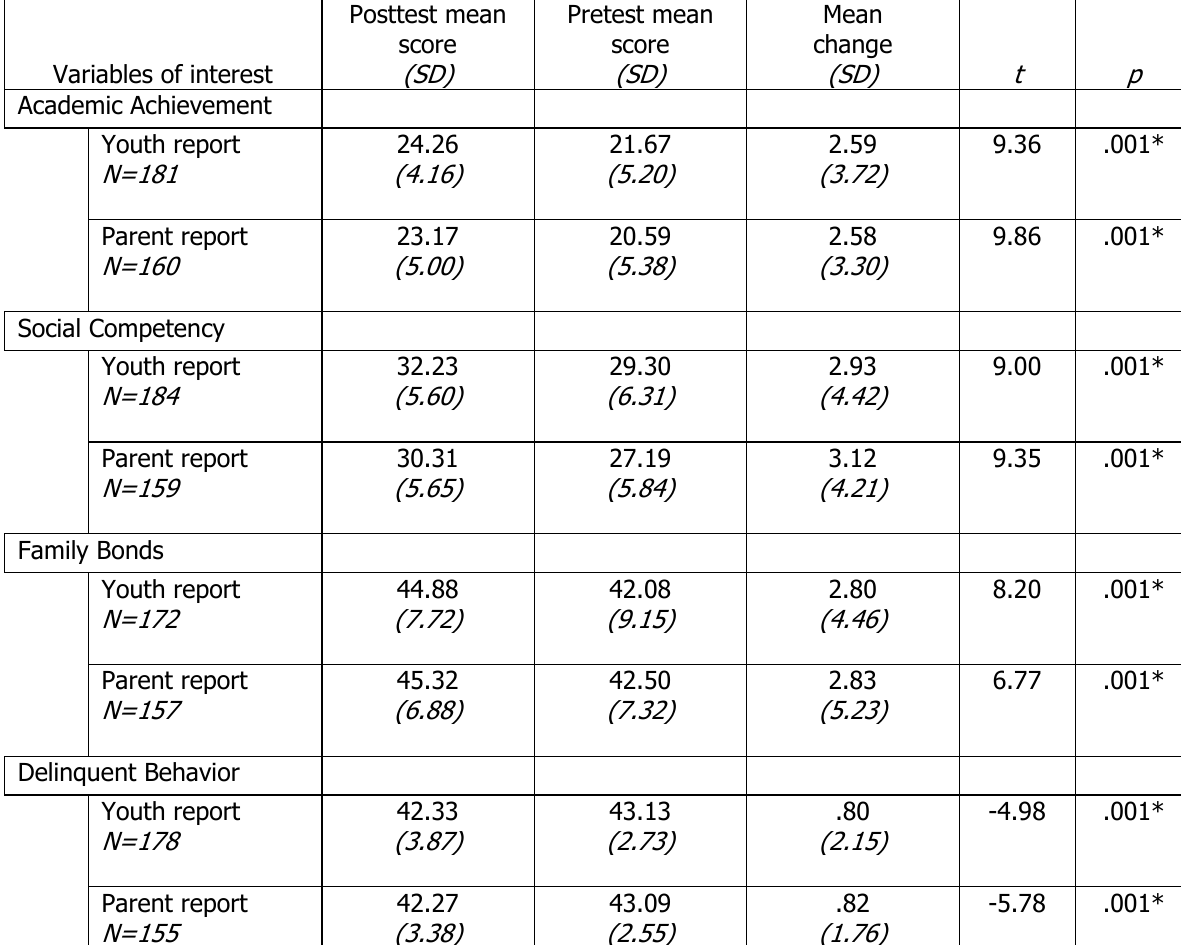
Paired-samples t -test results of youth and parents perceptions of academic achievement, social competency, family bonds, and delinquent